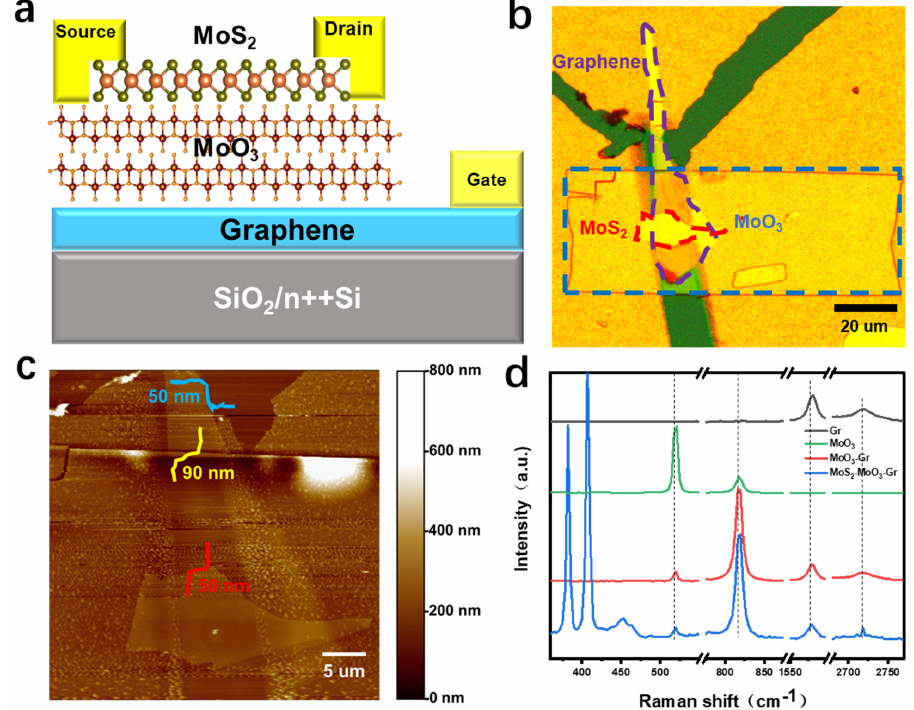
Figure 2. ( a ) Schematic diagram of Gr/MoO 3 /MoS 2 heterostructure. ( b ) Optical image of the device under optical microscope. ( c ) AFM surface topography of the device. ( d ) Raman spectra at different positions of the device.